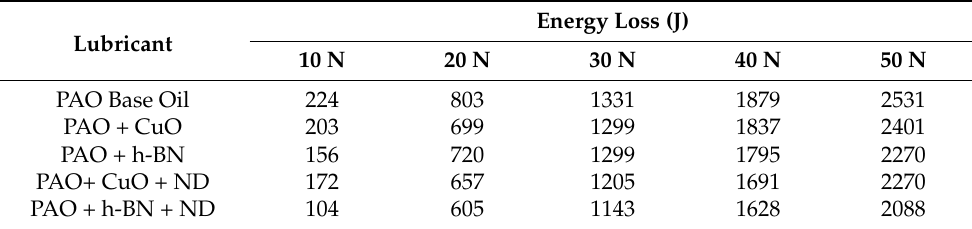
Table 5. Energy loss (J) due to sliding under lubrication with PAO base oil and the four nanolubricants at all loads. Lubricant